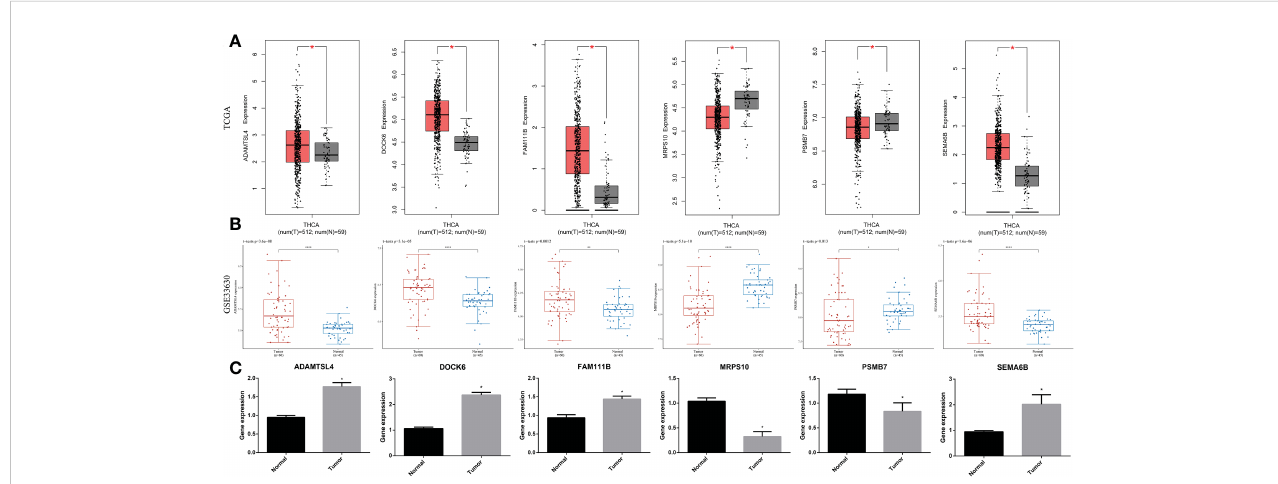
FIGURE 11 Expression of the signature gene. (A) Gene expression differences across TCGA dataset. (B) Gene expression differences across GSE33630. (C) RT-qPCR verifying the gene transcription in tumor and normal cells. * indicated P<0.05; ** indicated P<0.01; *** indicated